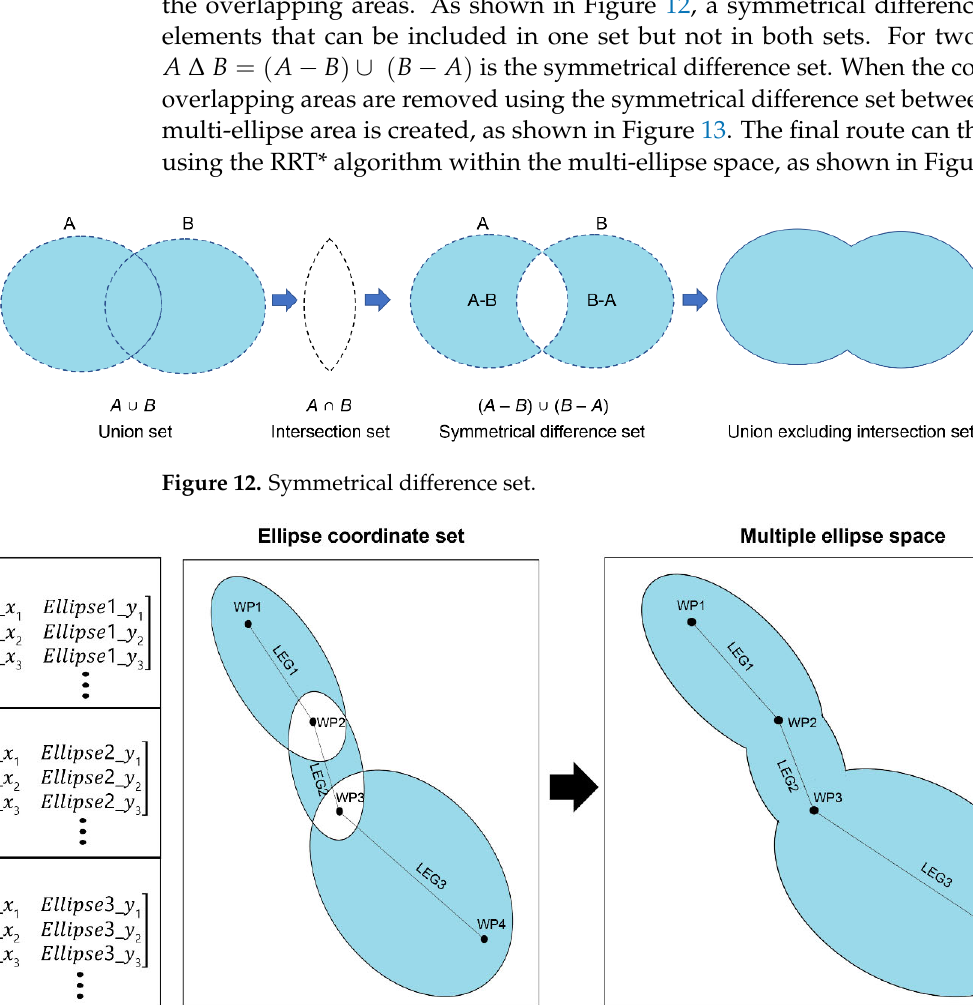
Figure 11. Characteristics of the ellipse.